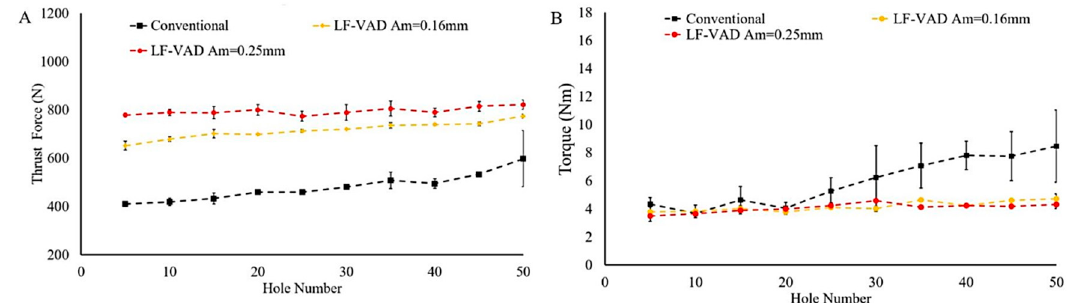
Figure 5. The effect of tool wear progress on the ( A ) thrust force and ( B ) cutting torque, at different vibration amplitude for N = 37.68 m/min and f = 0.075 mm/rev.